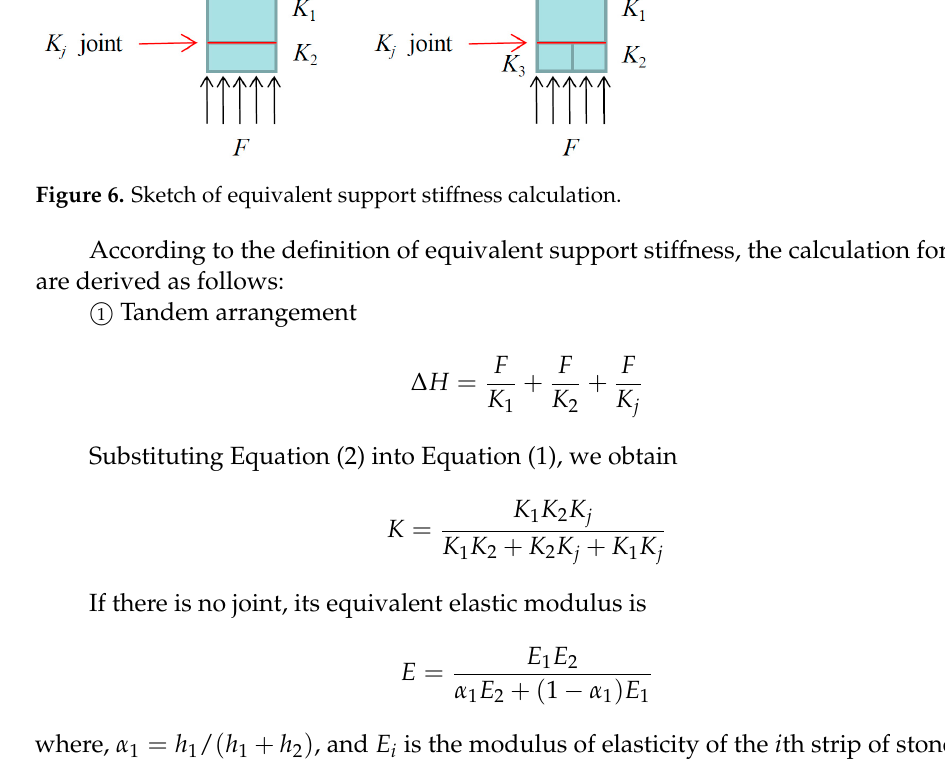
Figure 6. Sketch of equivalent support sti ff ness calculation